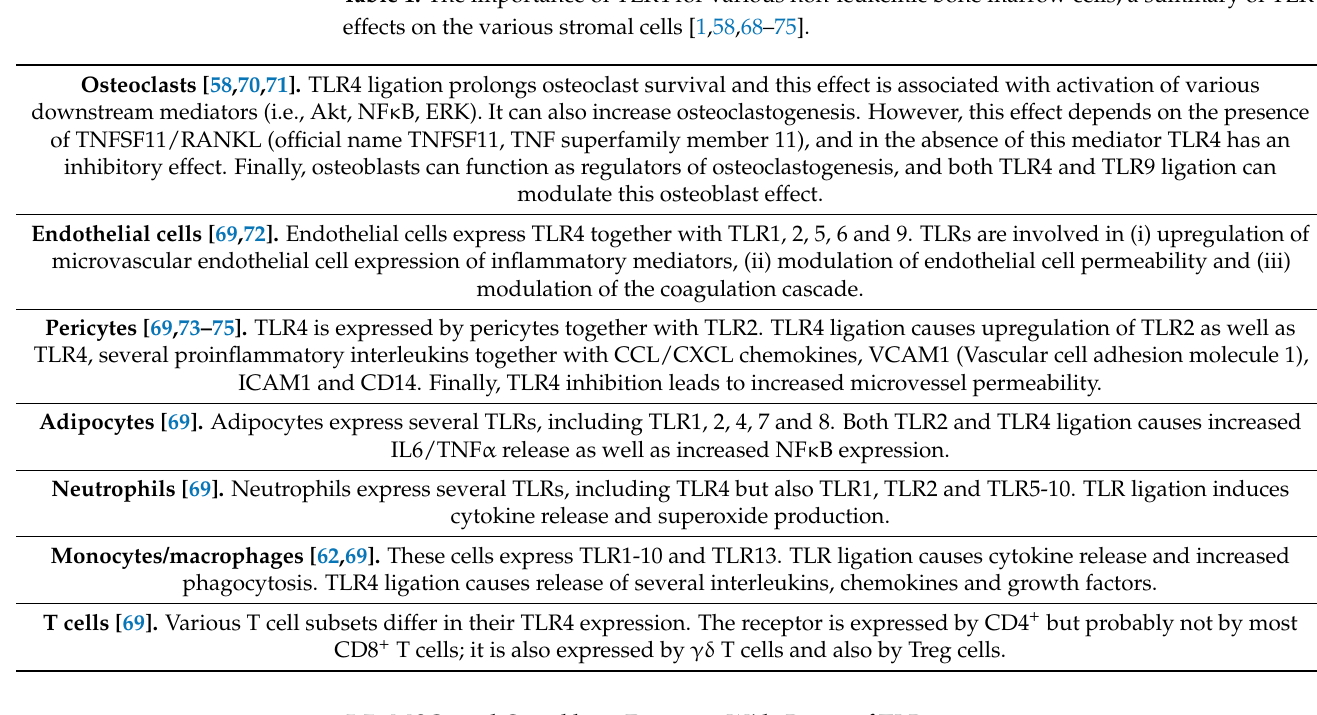
Table 1. The importance of TLR4 for various non-leukemic bone marrow cells; a summary of TLR4 effects on the various stromal cells